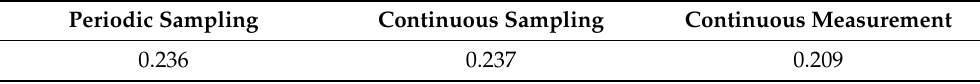
Table 6. Comparative CH 4 emission factor by sampling method (unit: gCH 4